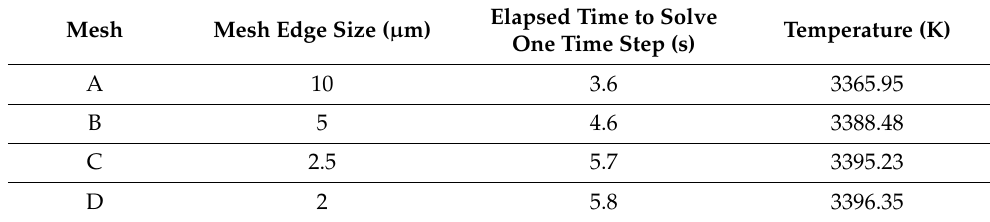
Table 3. Mesh density analysis.